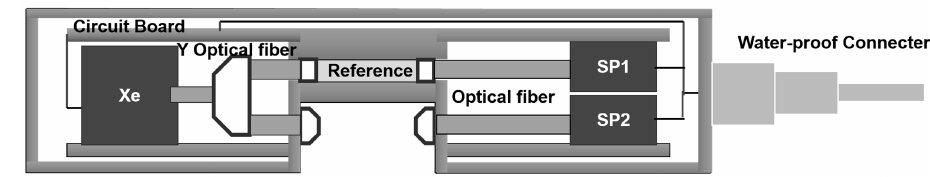
Figure A1. The scheme of Sensor 2.